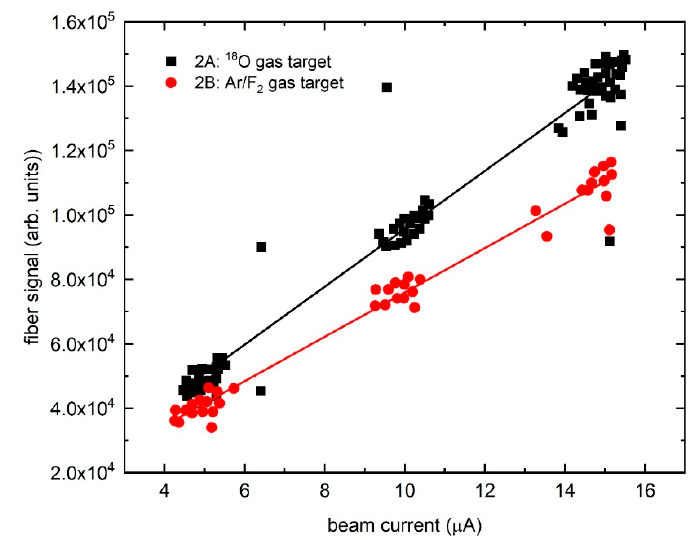
Figure 8. Graph comparing the difference in Ce-200 fiber signal between the irradiation of 18 O gas and Ar / F 2 mixture. The adjusted R 2 values are 0.9838 and 0.9945, respectively.